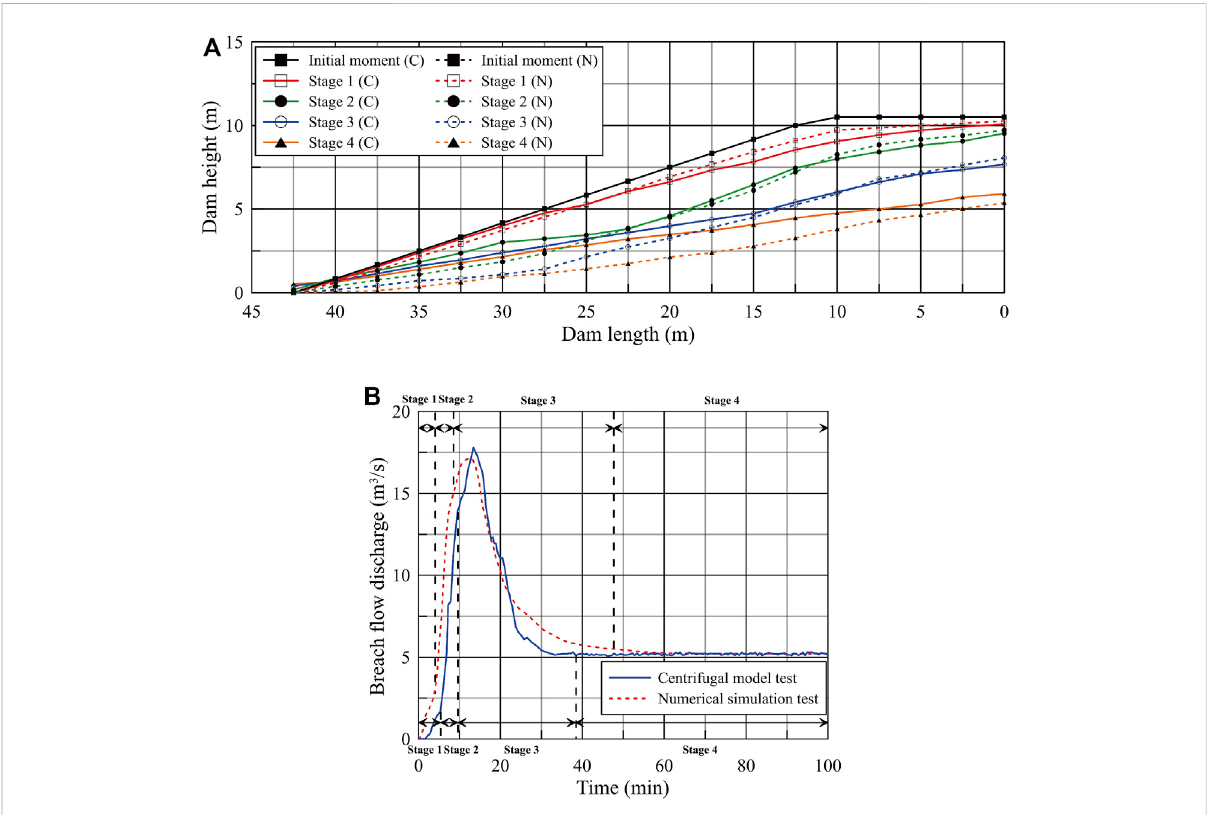
Figure 10A, where the C and N in brackets represent the centrifugal model test and numerical simulation test, respectively. Similar to the centrifugal model test, the dam breach process can also be divided into four